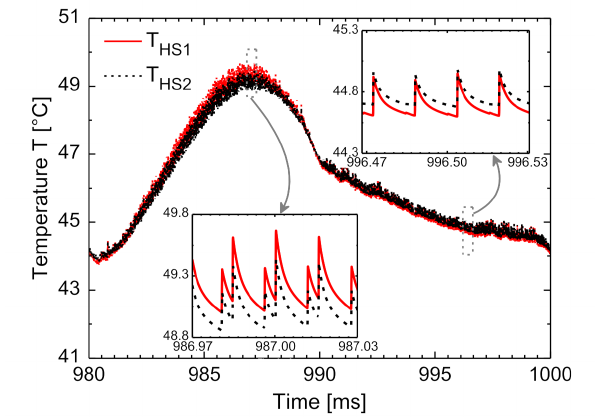
Figure 13. Simulated temperature of the HS devices vs. time in the last 20 ms window. Magnifications highlighting the temperature ripple in four-period-long windows are also reported on the bottom-left and top-right